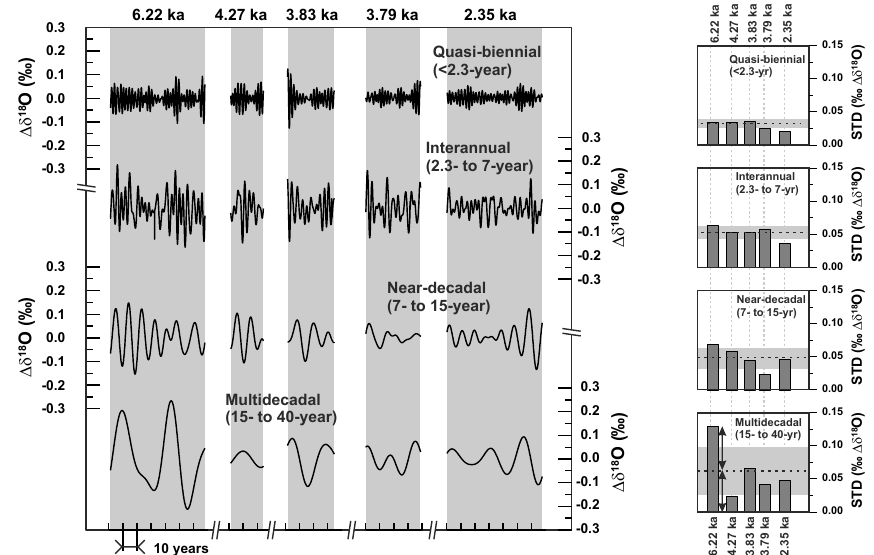
Fig. 8. Quasi-biennial, interannual, near-decadal and multidecadal Gaussian bandpass-filtered time series for individual coral 1δ 18 O records (from Fig. 7) with length > 20yr (left panel) and the corresponding standard deviations of filtered time series (right panels). Horizontal dashed lines and grey areas indicate the mean standard deviations (STD) of the filtered time series and the corresponding 2 σ , respectively. Black arrows indicate that the variance of the multidecadal bandpass-filtered time series of the 6.2ka coral 1δ 18 O record is twice as large as given by the corresponding mean standard deviation of all coral records.